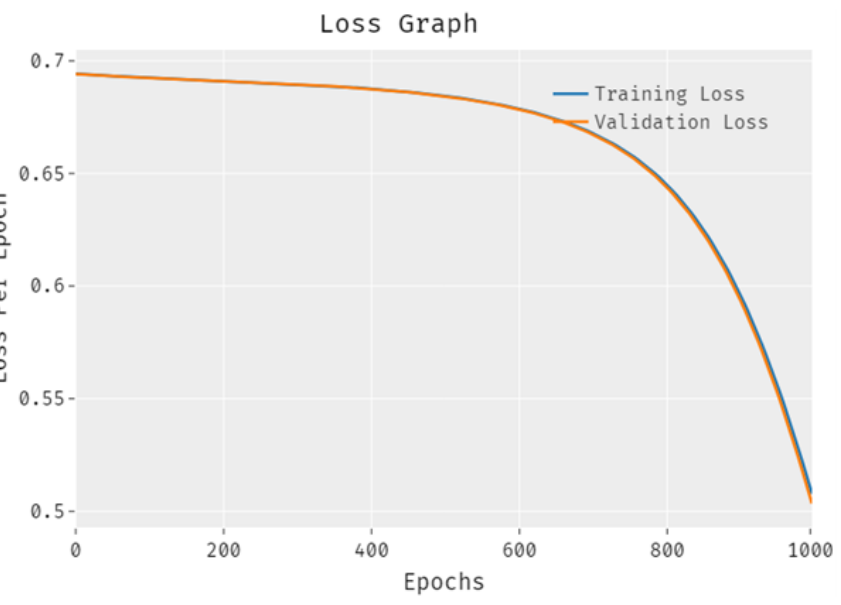
Figure 7. Loss analysis of ESOML-IDS technique under 1000